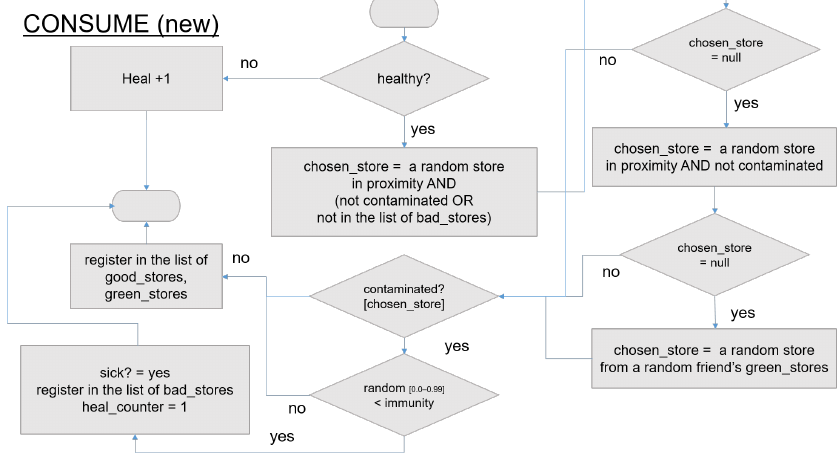
Figure 7. The Proposed CONSUME Process for Consumers with Social Networking